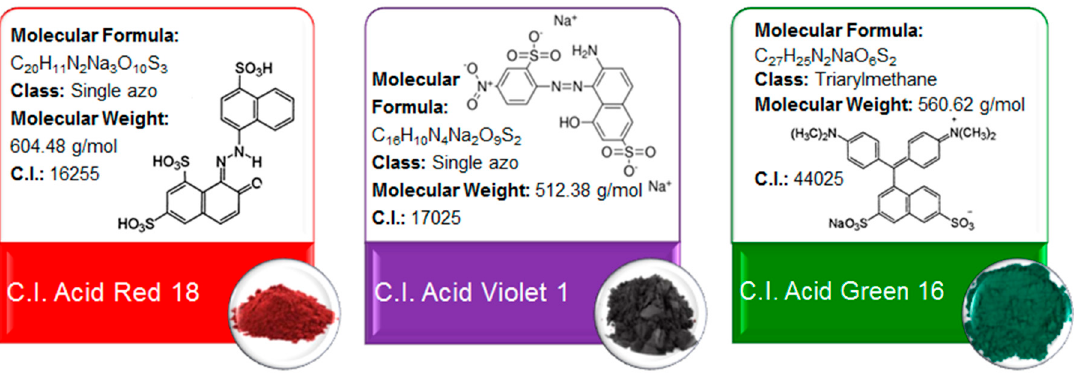
Figure 10. Dye characteristics. Figure 10. Dye